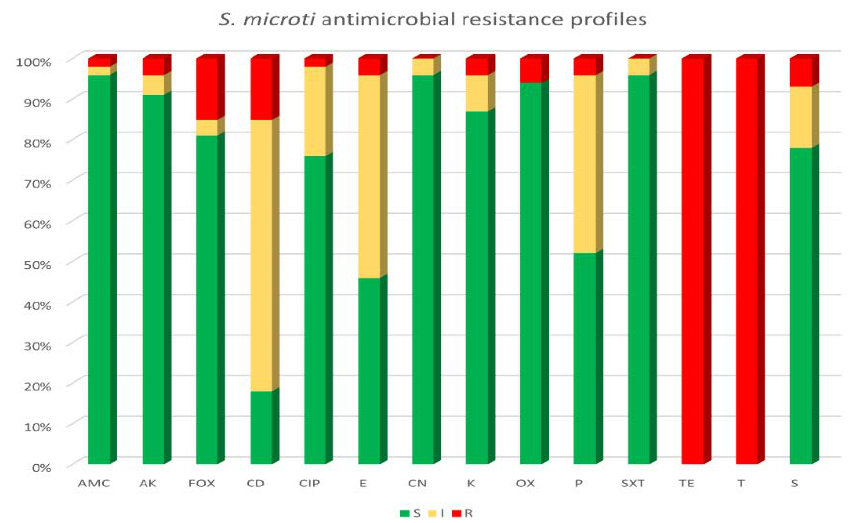
Figure 1. Antibiotic resistance profiles of 54 S. microti isolates. Tested antibiotics: amoxicillin– clavulanate (AMC), amikacin (AK), cefoxitin (FOX), clindamycin (CD), ciprofloxacin (CIP), ery- thromycin (E), gentamicin (CN), kanamycin (K), oxacillin (OX), penicillin (P),